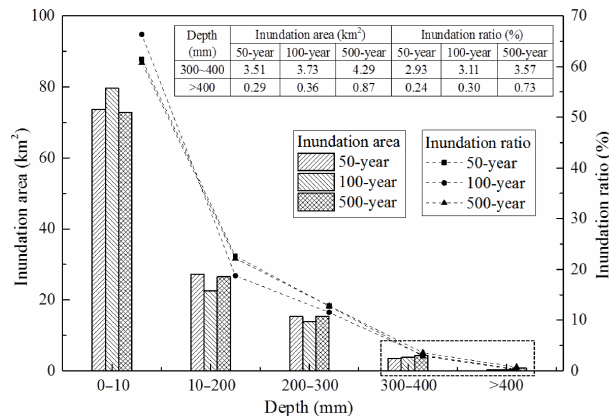
Figure 6. Statistical inundation area with the corresponding ratio at different